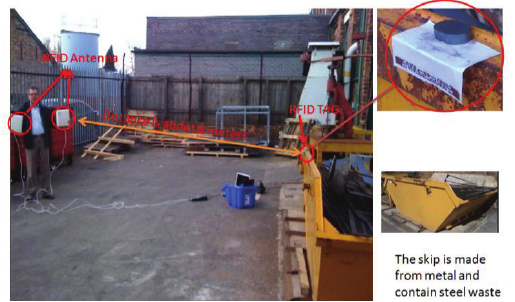
Fig. 3. Experiments for RFID Reading Range in a Large Metal Object